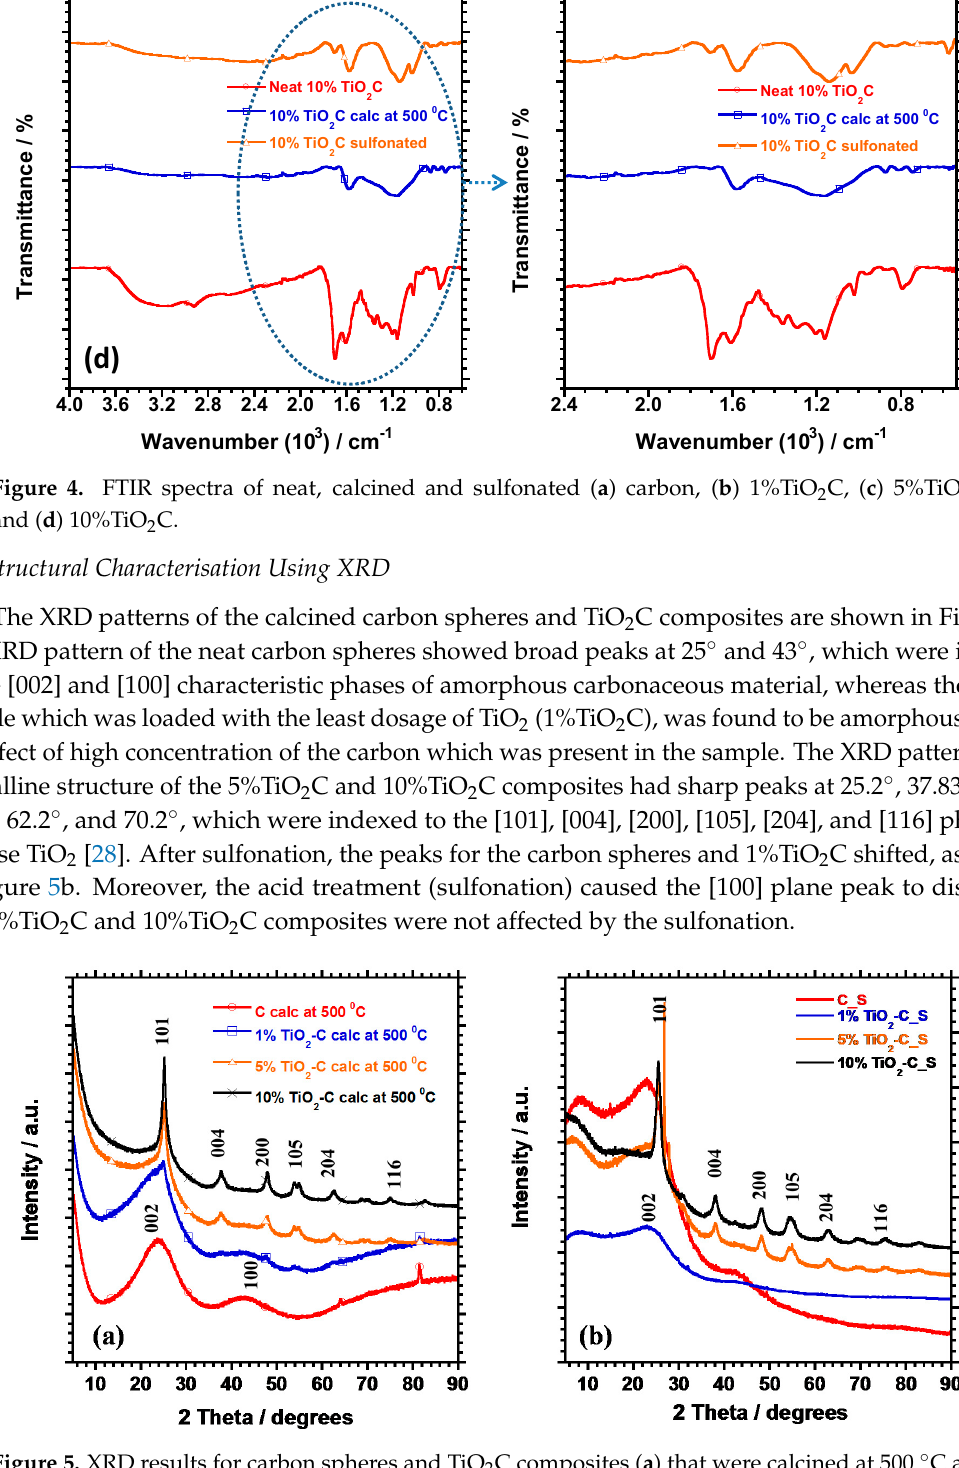
Figure 5. XRD results for carbon spheres and TiO 2 C composites ( a ) that were calcined at 500 °C and ( b ) after sulfonation.